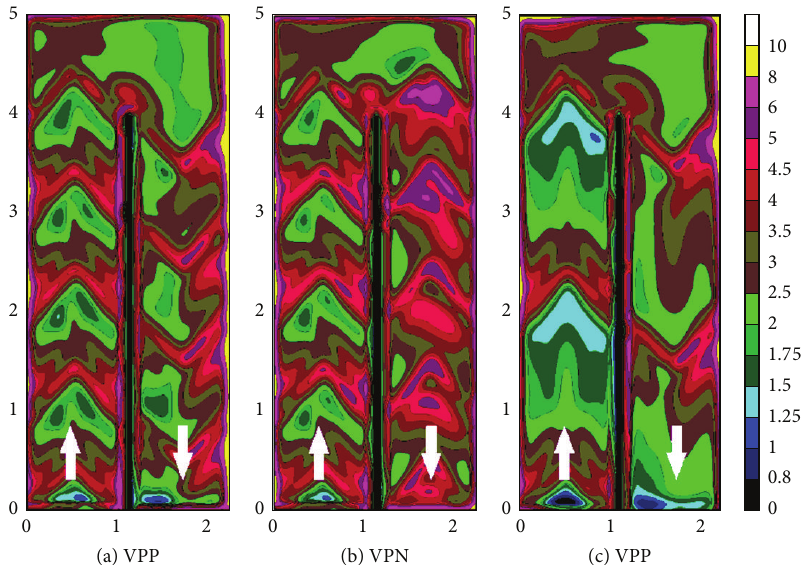
Figure 11: Nu / Nu ∗ distribution for a channel with superimposed ribs, Re = 30,000: (a) VPP, 𝑝/𝑒 = 10 ; (b) VPN, 𝑝/𝑒 = 10 ; (c) VPP, 𝑝/𝑒 = 20 ; adapted from Astarita et al.